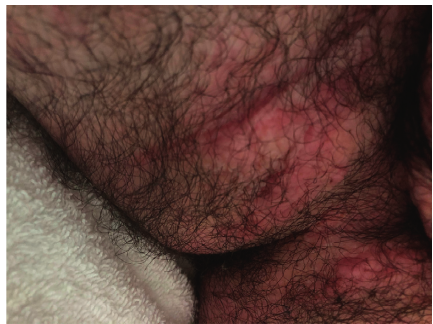
Figure 2: Improvement following 8 months of treatment with adalimumab.